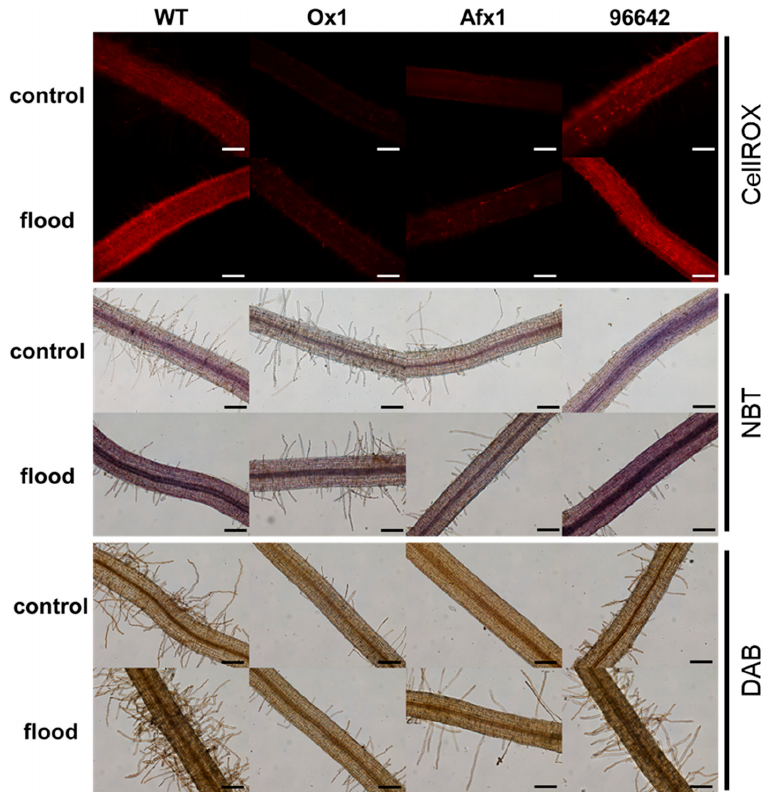
Figure 6. ROS in roots of flooded and unflooded (control) plants. Oxidative activity of ROS was detected with the CellROX probe, superoxide with NBT and hydrogen peroxide with DAB. Scale bars, 100 μ m.